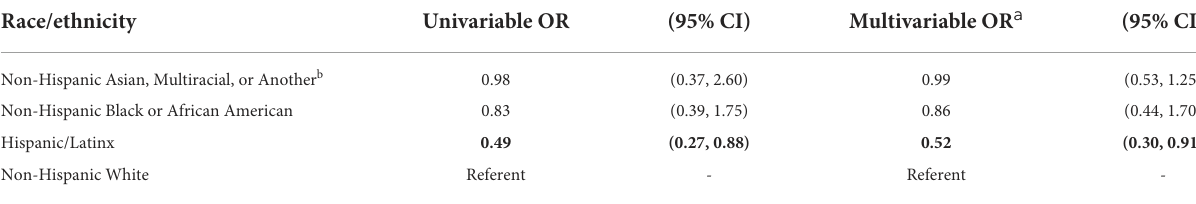
TABLE 5 Association between race/ethnicity and CT scan use during adult concussion emergency department visits.